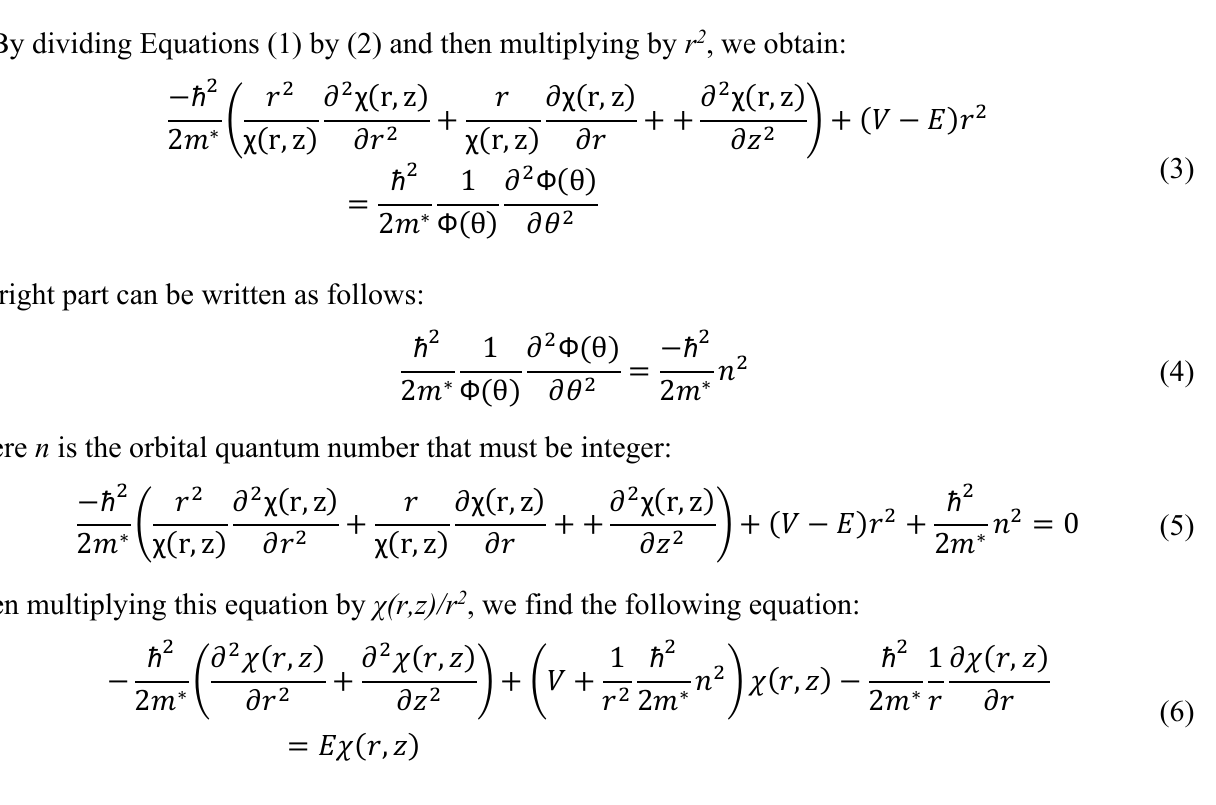
Figure 1. Schematic presentation of the zoomed lens shaped InAs quantum dots (QD) in a GaAs matrix. Also shown is the adaptive mesh refinement around the QD and the wetting